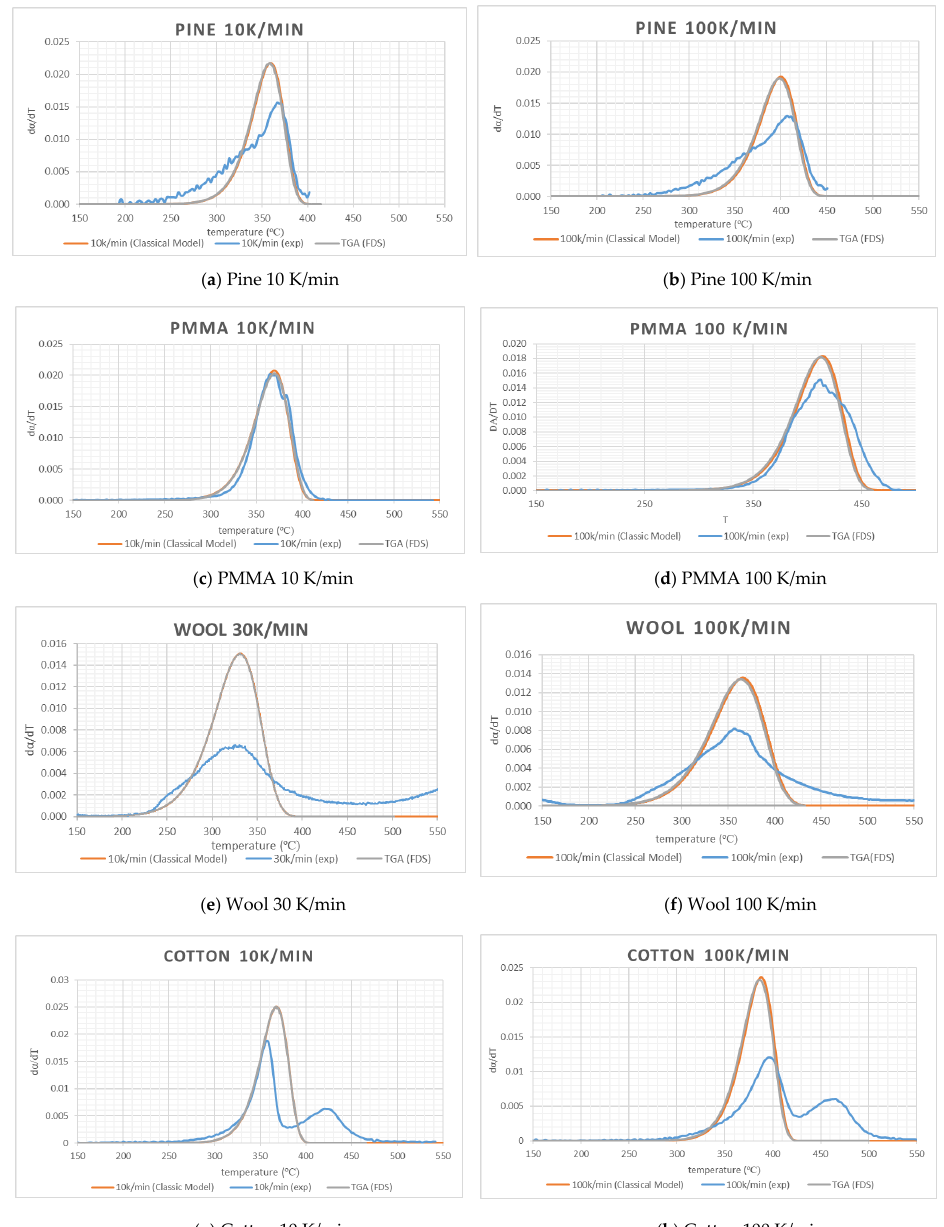
Figure 3. Experimental data and simulation data using kinetics data.